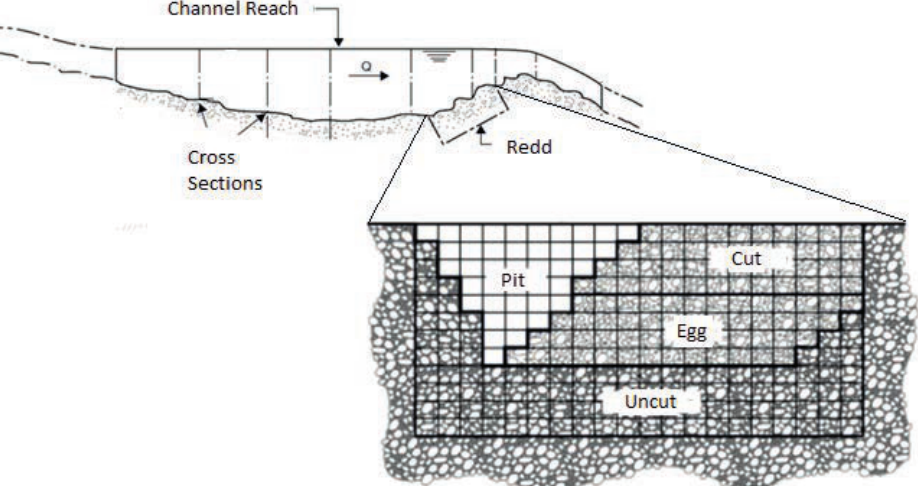
Fig. 1 The representation of a channel reach by the SIDO-UK model (modified from Alonso et al .,